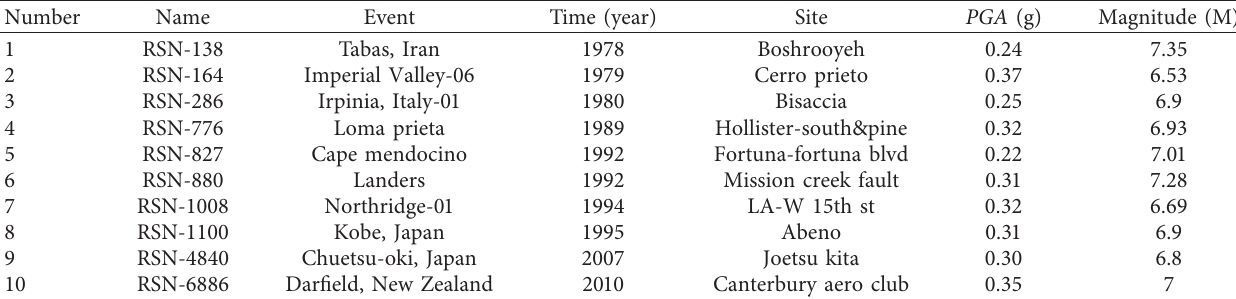
Table 2: Details of 10 ground motions.